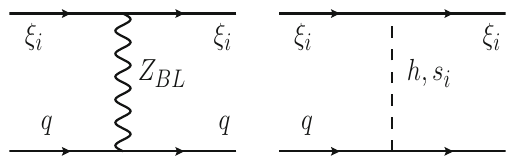
Fig. 1 Feynman diagrams for spin-independent elastic scattering pro- cesses of DM with nucleons (or quarks) in the